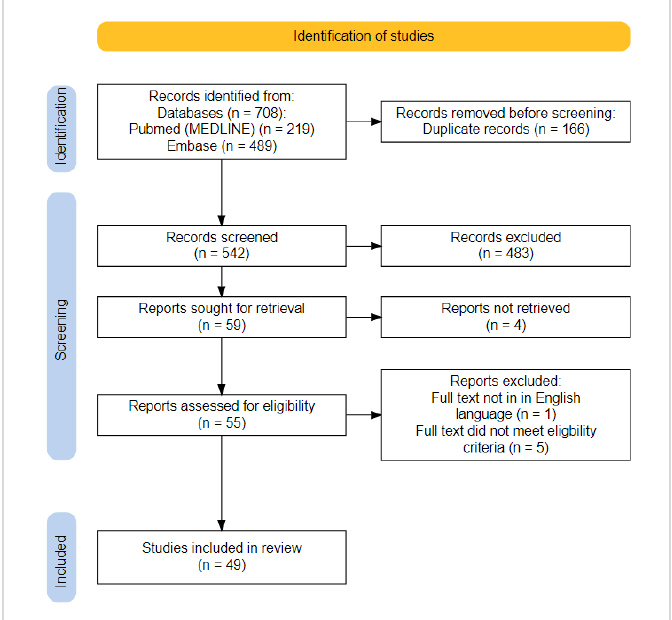
Figure 2. PRISMA flowchart.